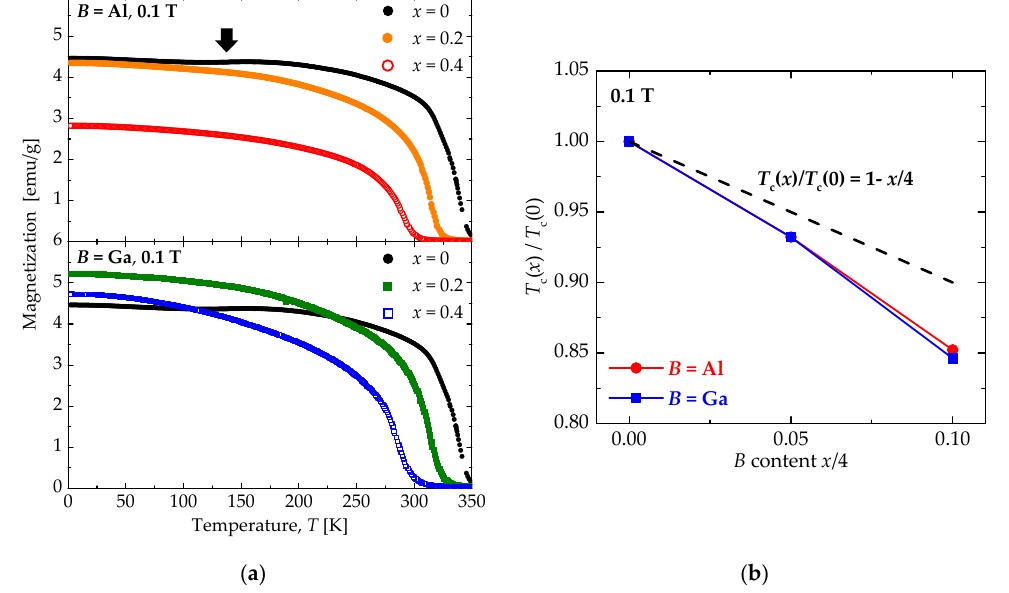
Figure 3. ( a ) Temperature dependence of the magnetization of Sr 3.1 Y 0.9 Co 4− x B x O 10.5 ( B = Al and Ga: x = 0, 0.2, and 0.4) under 0.1 T. ( b ) The normalized Curie temperature ( T c ( x )/ T c (0)) of Sr 3.1 Y 0.9 Co 4− x B x O 10.5 by T c of Sr 3.1 Y 0.9 Co 4 O 10.5 as a function of substitution ratio of Co by B ( x /4). T c has been estimated from the inflection points in the temperature derivative of the M – T curve.